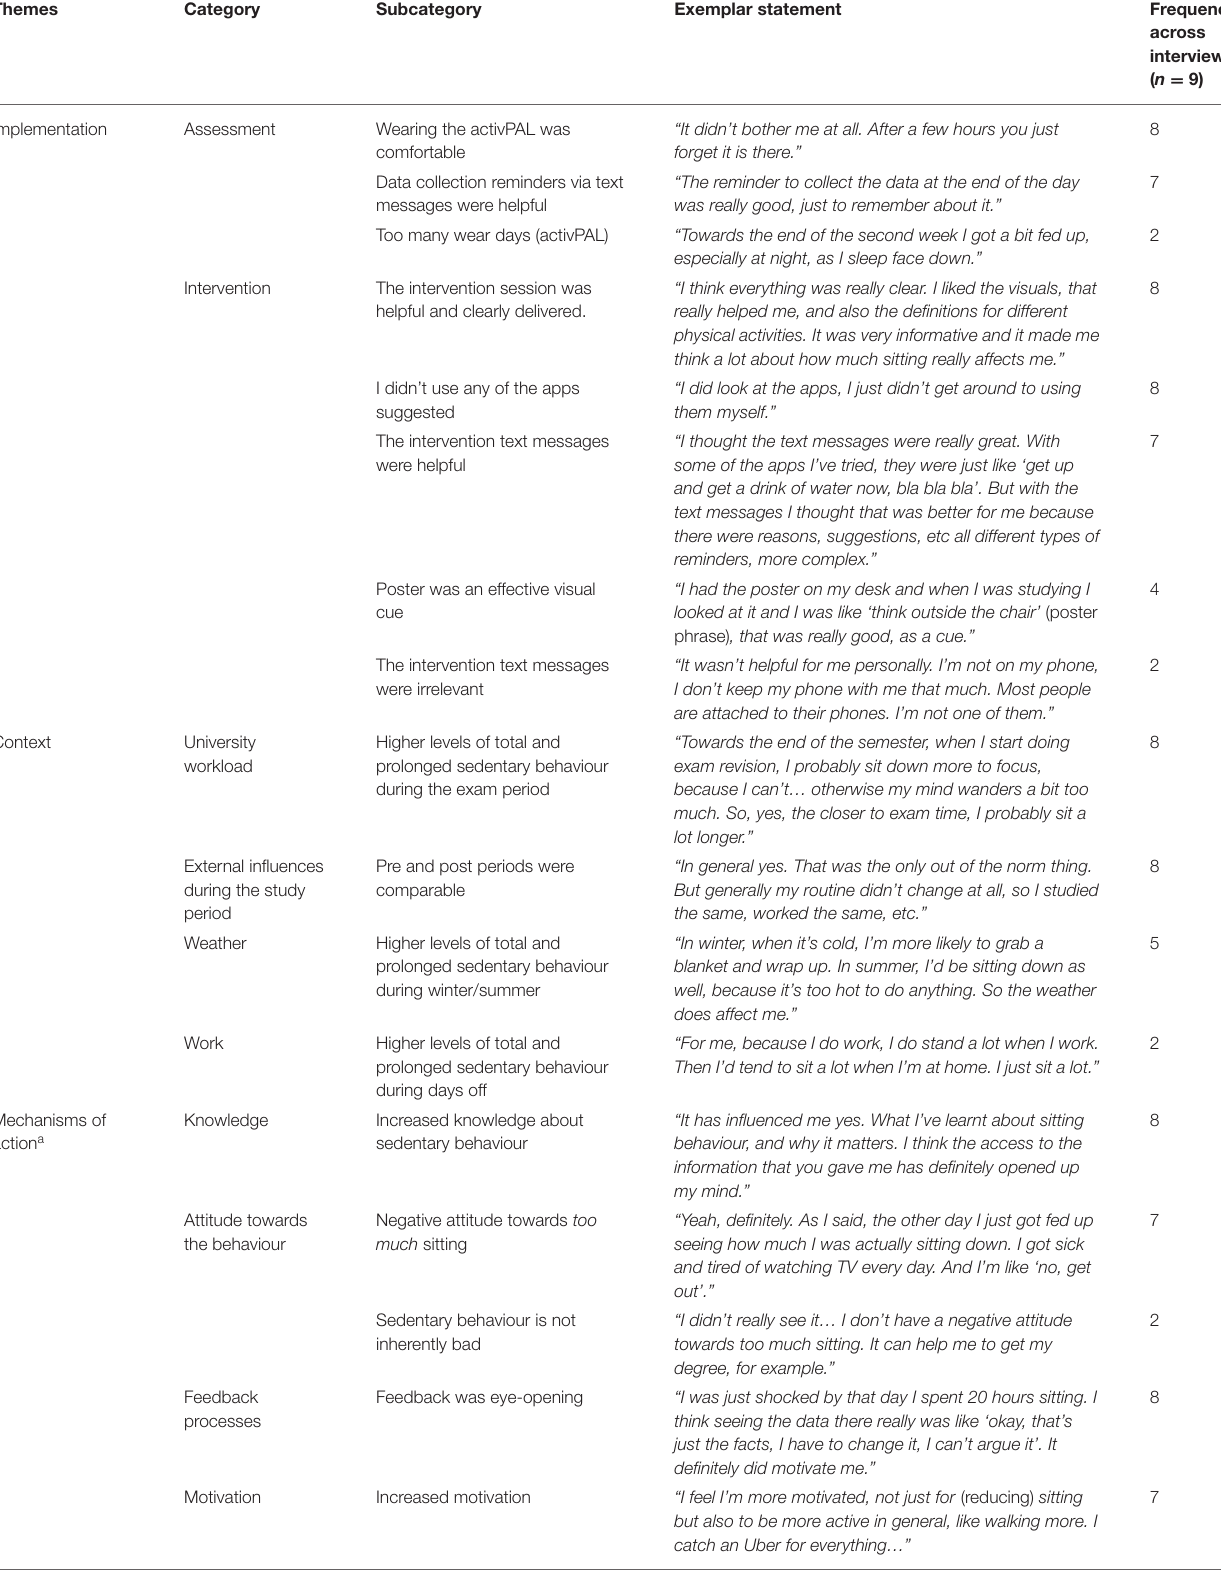
TABLE 6 | Themes elicited from process evaluation interviews with University students ( n = 9).